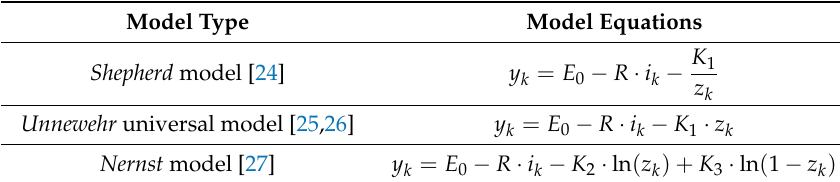
Table 1. Typical empirical